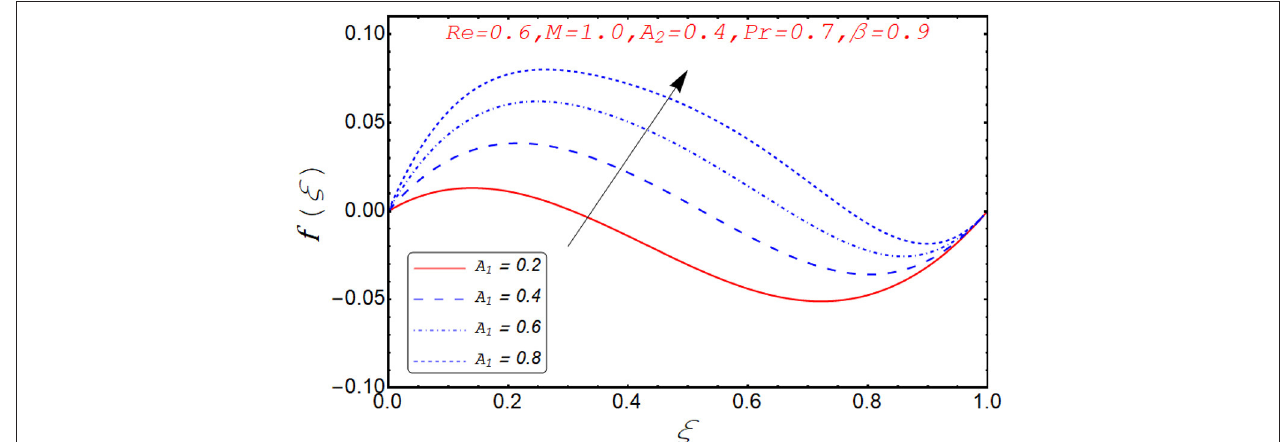
FIGURE 5 | Behavior of f ( ξ ) for different A 1 .